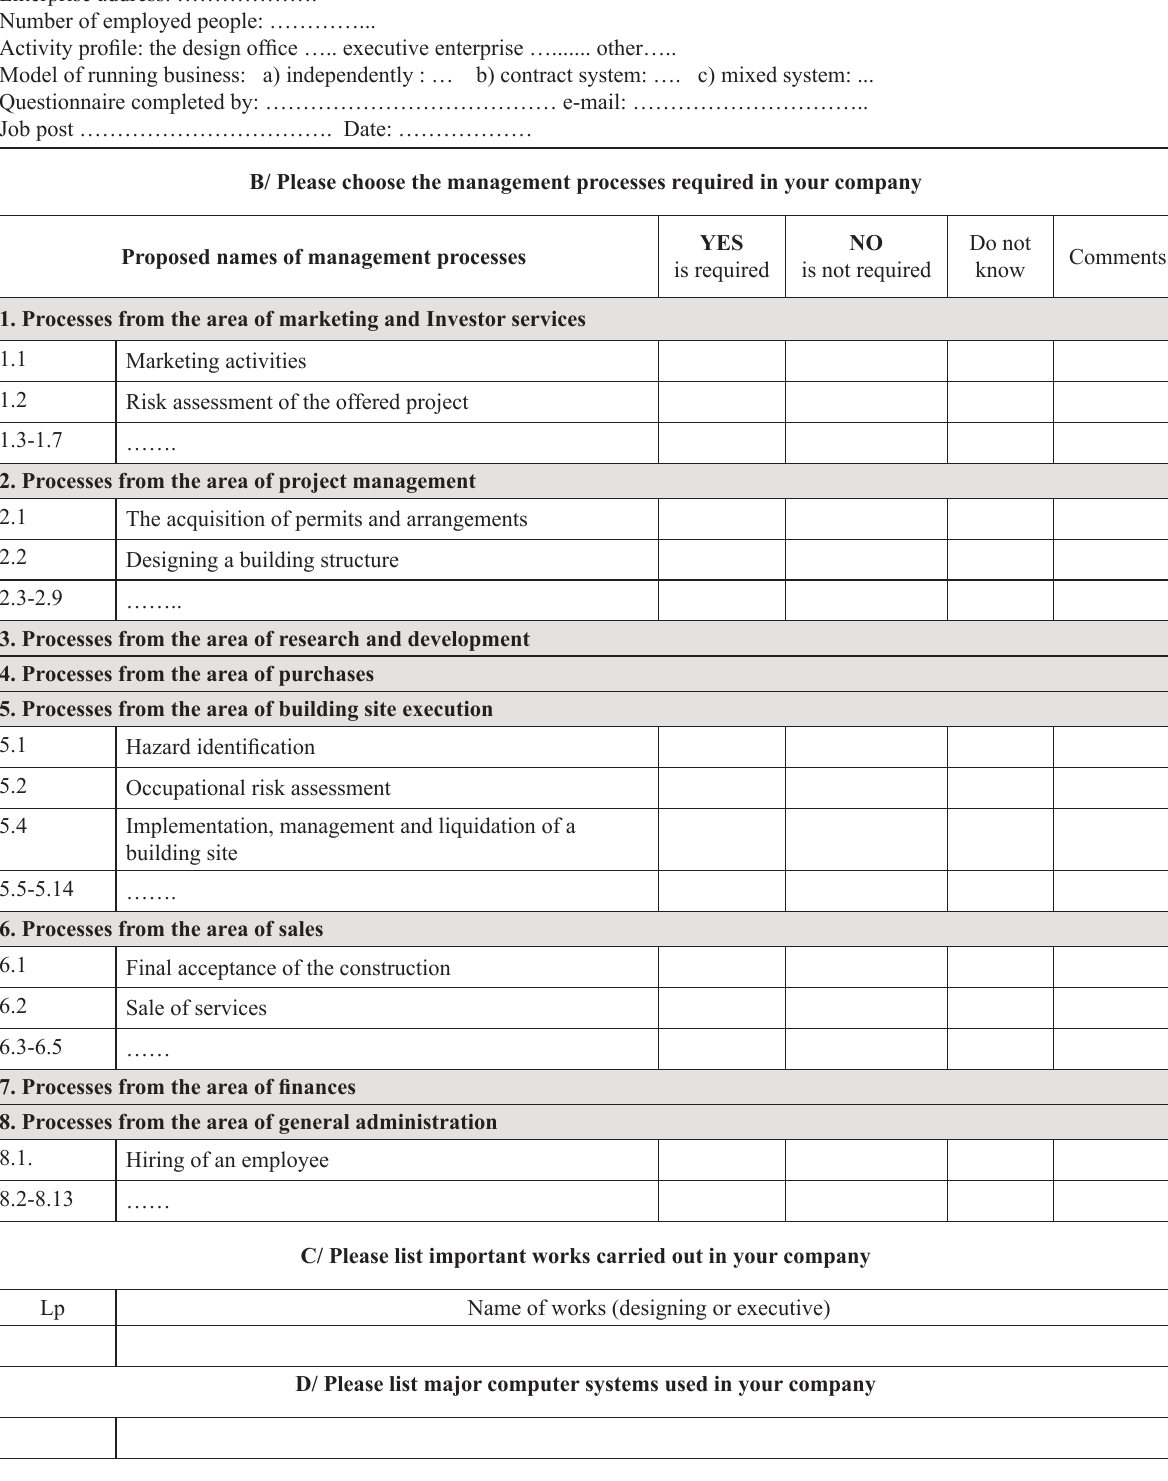
Table 1. a fragment of the research questionnaire enterprise name: ……………… enterprise address: ………………. number of employed people: